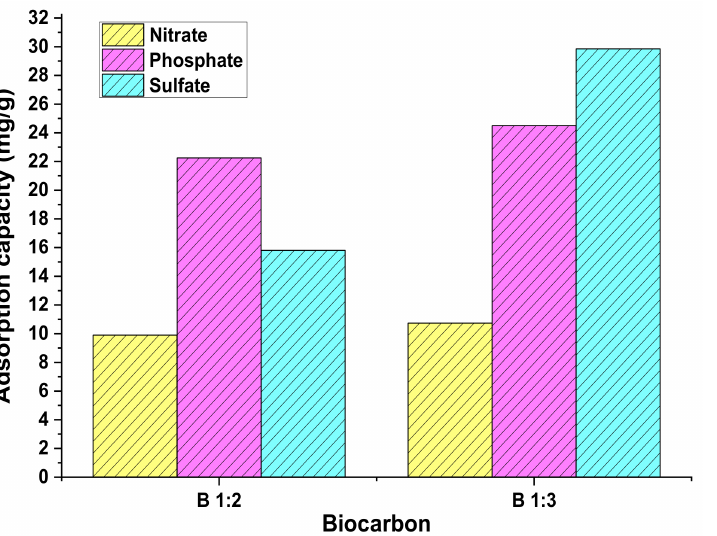
Figure 2. Competitive adsorption of nitrate, sulphate, and phosphate; source: own